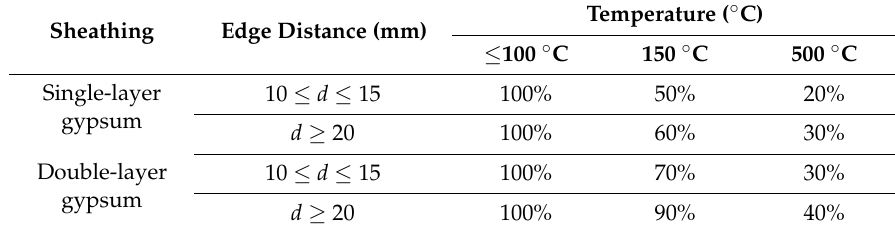
Figure 16. Predicted values of Δ 1T . Table 4. Values of R kT in Equation (6).